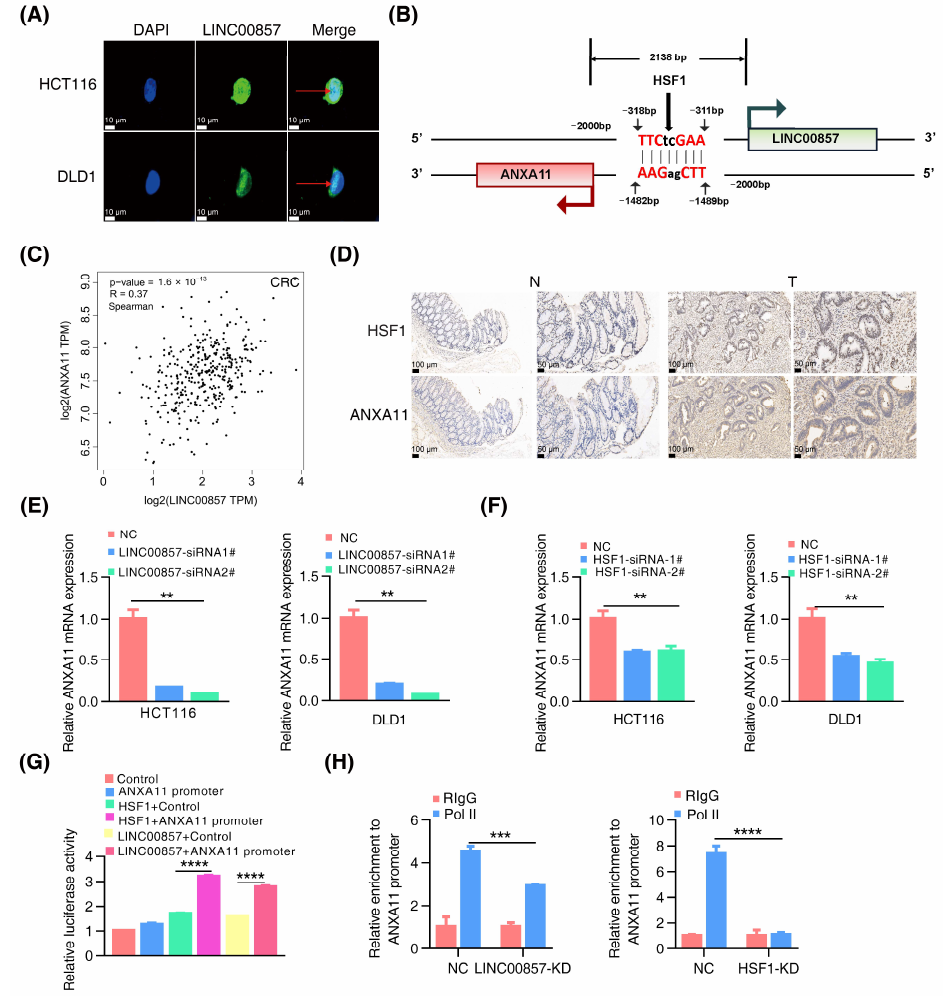
Figure 5. The HSF1/LINC00857 axis promotes the transcription of ANXA11. ( A ) Subcellular local- ization of LINC00857 in HCT116 and DLD1 by FISH (scale bar, 10 µm). ( B ) Diagram of LINC00857 promoter regions. The scatter plot of the relationship between HSF1, LINC00857, and ANXA11. ( C ) Correlation between LINC00857 and ANXA11 expression using the GEPIA database. ( D ) HSF1 and ANXA11 expression levels as detected in the normal and tumor tissues by IHC (immunohistochem- istry) (scale bar, 50 µm and 100 µm). ( E ) Relative ANXA11 mRNA expression after LINC00857 knockdown. ( F ) Relative ANXA11 mRNA expression after HSF1 knockdown. ( G ) Relative luciferase activity after transfection HSF1, LINC00857, and ANXA11 promoter. ( H ) Relative enrichment level of RNA Pol II at the ANXA11 promoter after LINC00857 or HSF1 knockdown by ChIP–qPCR assays. All data represent the mean ± SD, n = 3. ** p < 0.01; *** p < 0.001; **** p < 0.0001.